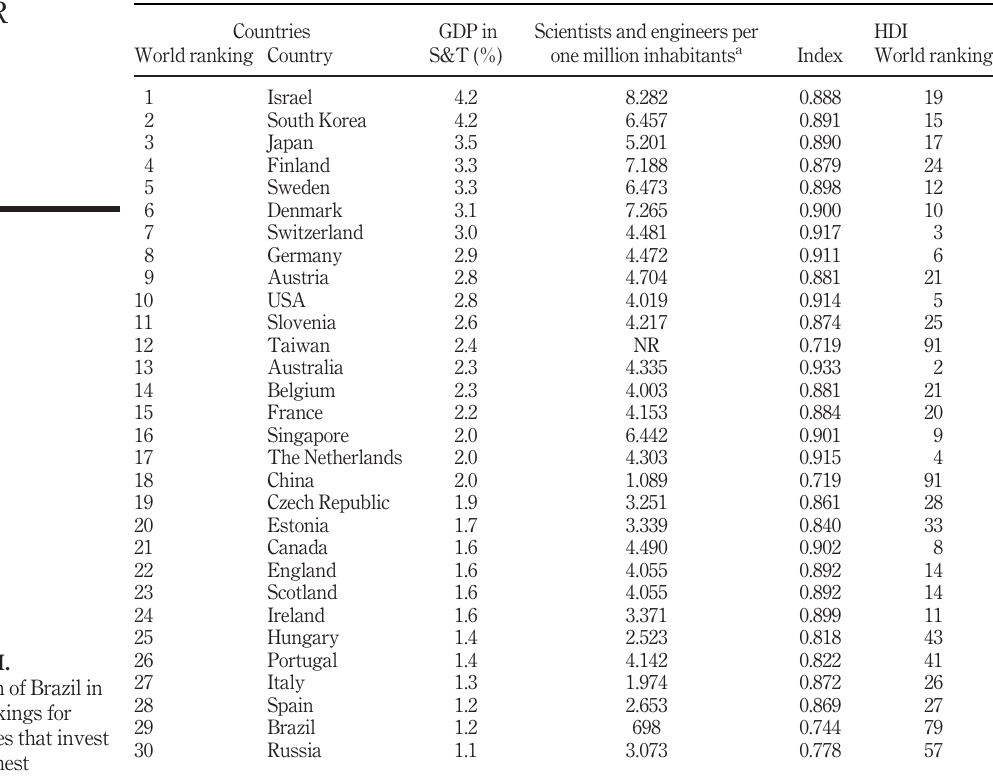
Table I. Position of Brazil in the rankings for countries that invest the highest percentages of GDP Note: a Number of scientists and engineers per 1 million inhabitants and respective HDIs in S&T Source: Zanotto and Guimarães